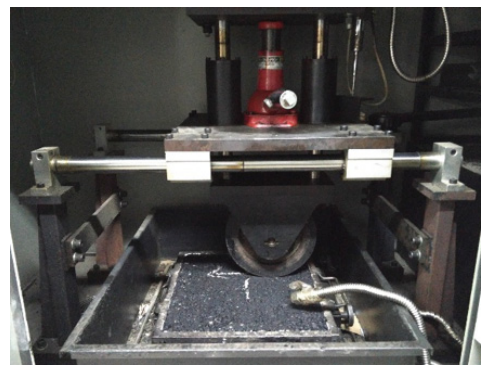
Figure 2. Rut test instrument.